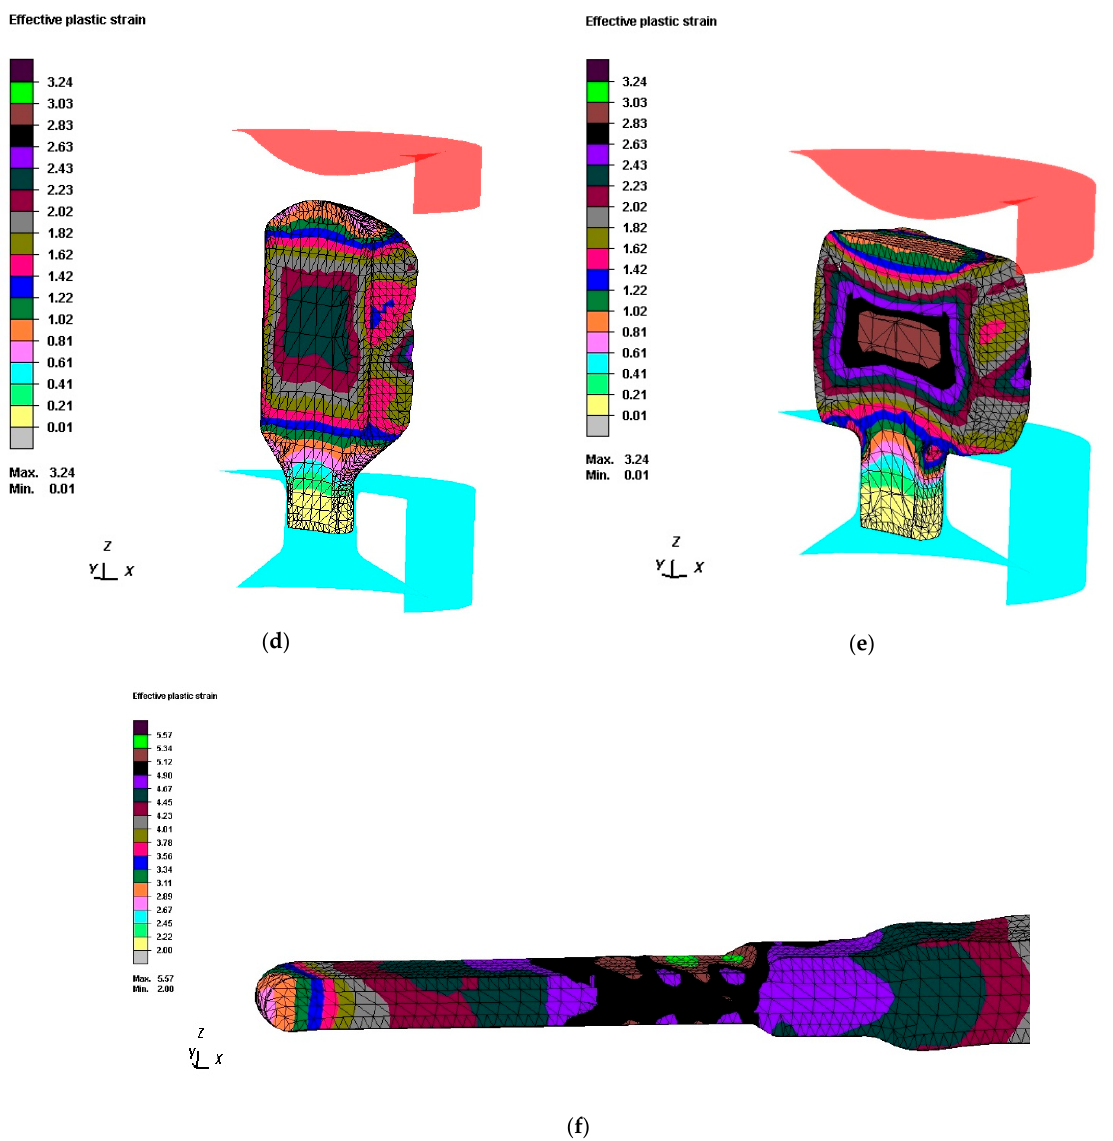
Figure 5. Procedure of numerical simulation of forging process of plate from a conventional 8K polygonal forging ingot. ( a ) A parallel octagon body of the 8K ingot with equivalent diameter of 1200 mm. ( b ) Cross section view of upsetting of the ingot 8K between flat swaging dies. ( c ) Forging to rectangle cross section billet between flat dies. ( d ) Upsetting of rectangle cross section billet between flat swaging dies. ( e ) The shape of the billet after the second upsetting between flat swaging dies. ( f ) Scheme 310 mm of thickness from an initial conventional 8K polygonal ingot.